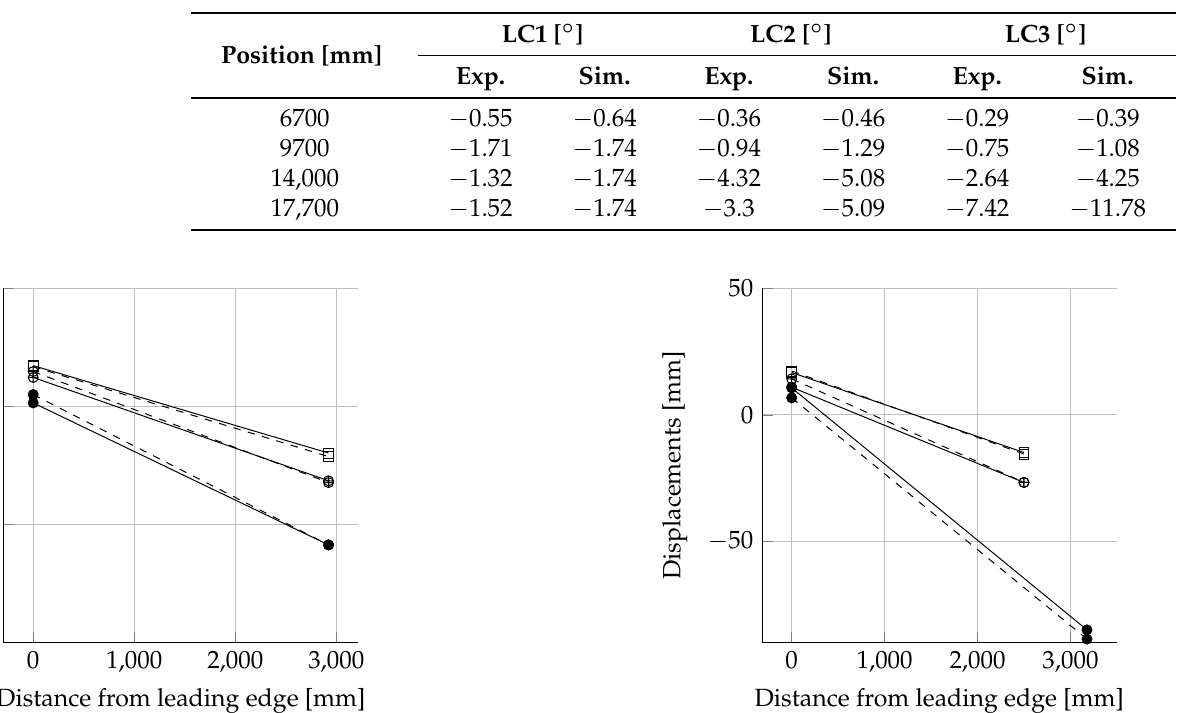
Table 6. Torsion angles at various positions.